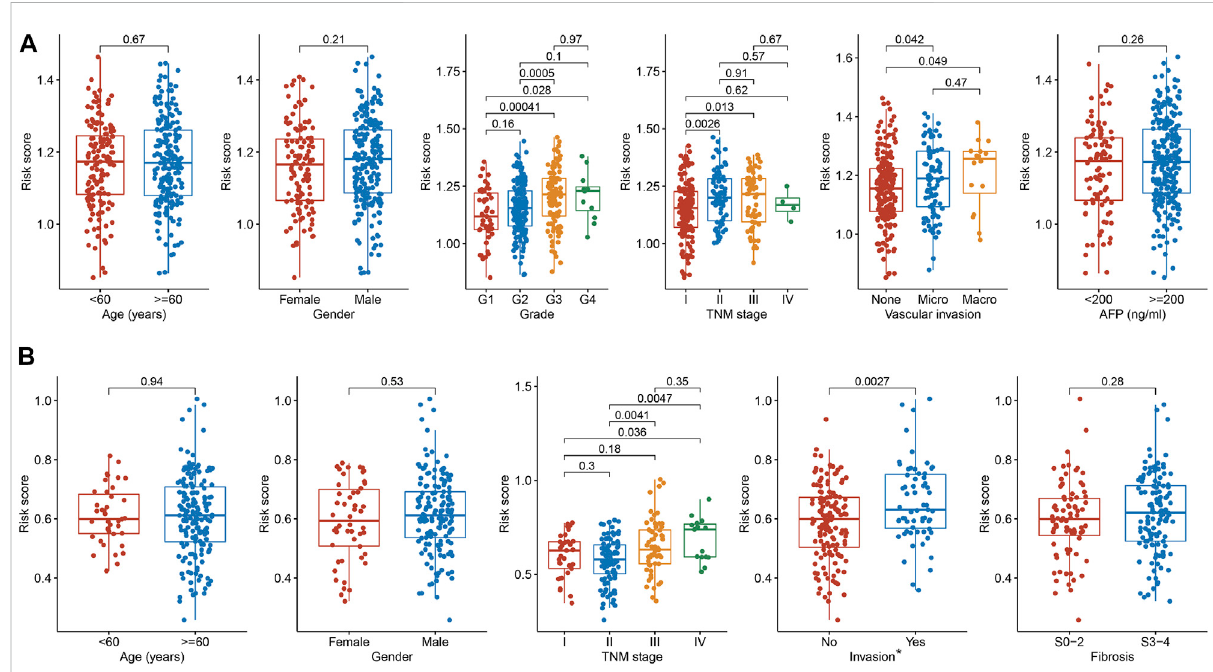
FIGURE 5 TherelationshipsbetweentheTFsignatureandclinicalindicators (A) Thecorrelationsofriskscorewithage,gender,grade,TNMstage,vascular invasion and AFP level in the TCGA cohort (B) The correlations of risk score with age, gender, TNM stage, invasion and fi brosis in the ICGC cohort. * Portal vein, vein or artery invasion; TF, transcription factor; AFP, alpha-fetoprotein; TCGA, The Cancer Genome Atlas; ICGC, International Cancer Genome